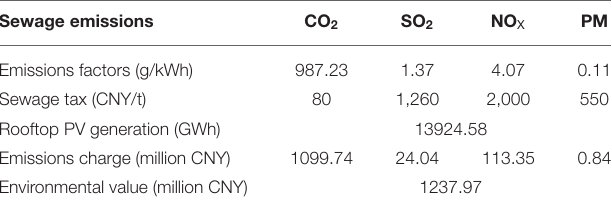
TABLE 5 | Emissions factors and sewage tax for coal power and environmental value of DPV in